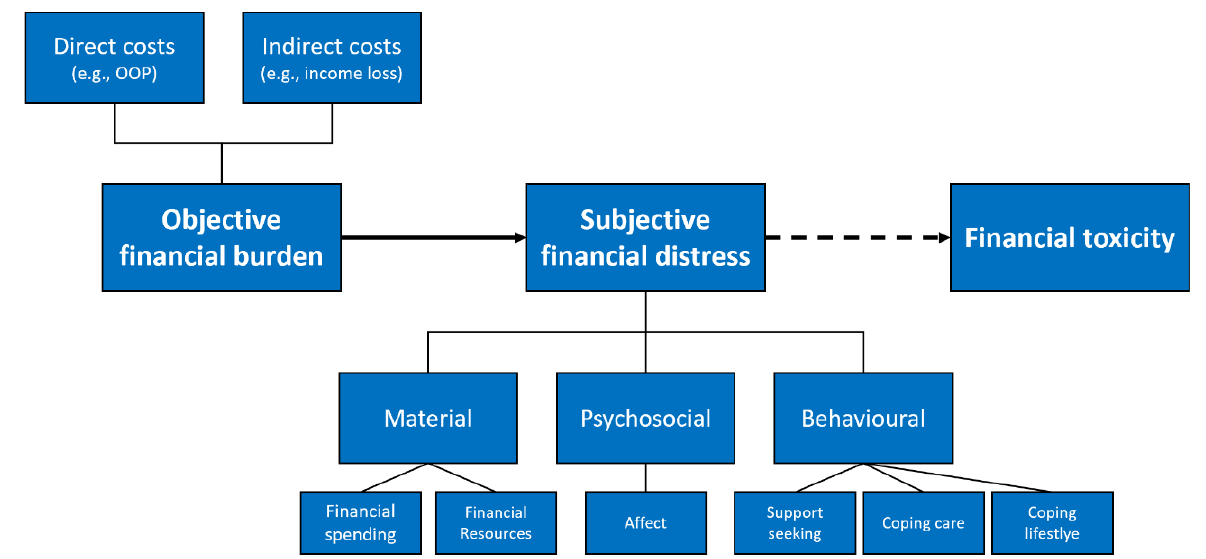
Figure 1. Framework of financial toxicity by Witte et al. [4].